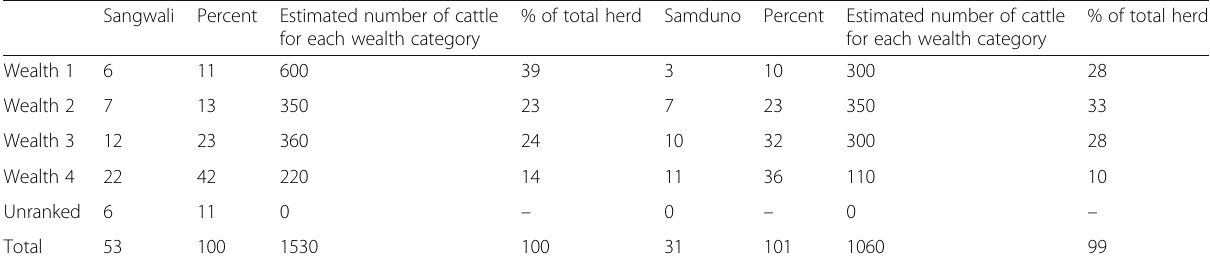
Table 2 Cattle owners arranged according to wealth categories resulting from a wealth-ranking exercise Sangwali Percent Estimated number of cattle % of total herd Samduno Percent Estimated number of cattle for each wealth category for each wealth